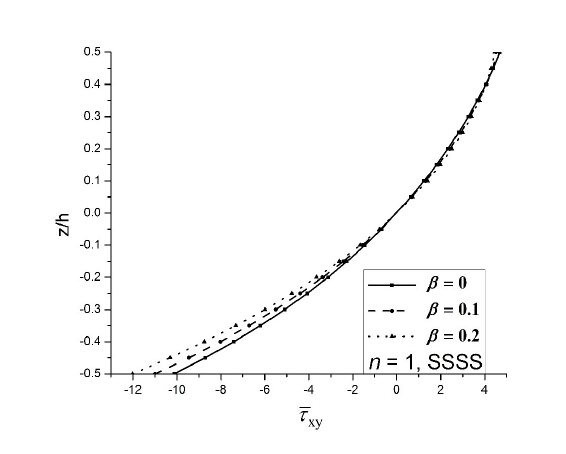
Figure 8: Effect of porosity on dimensionless shear stress of FGM-1 porous conoidal shell under uniform